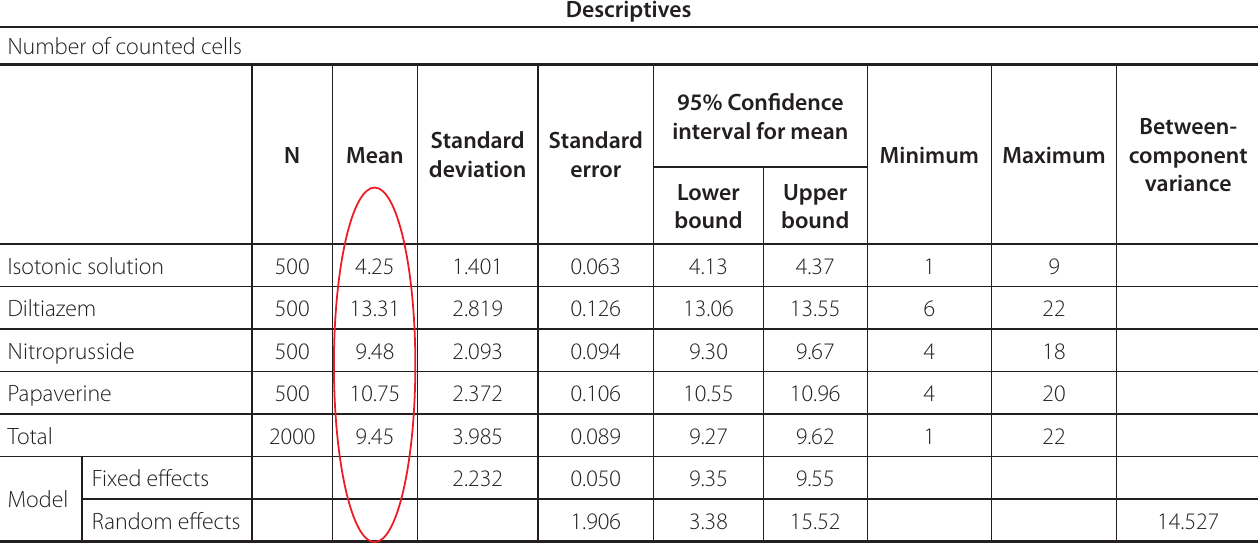
Table 1 . Number of apoptotic cells in different